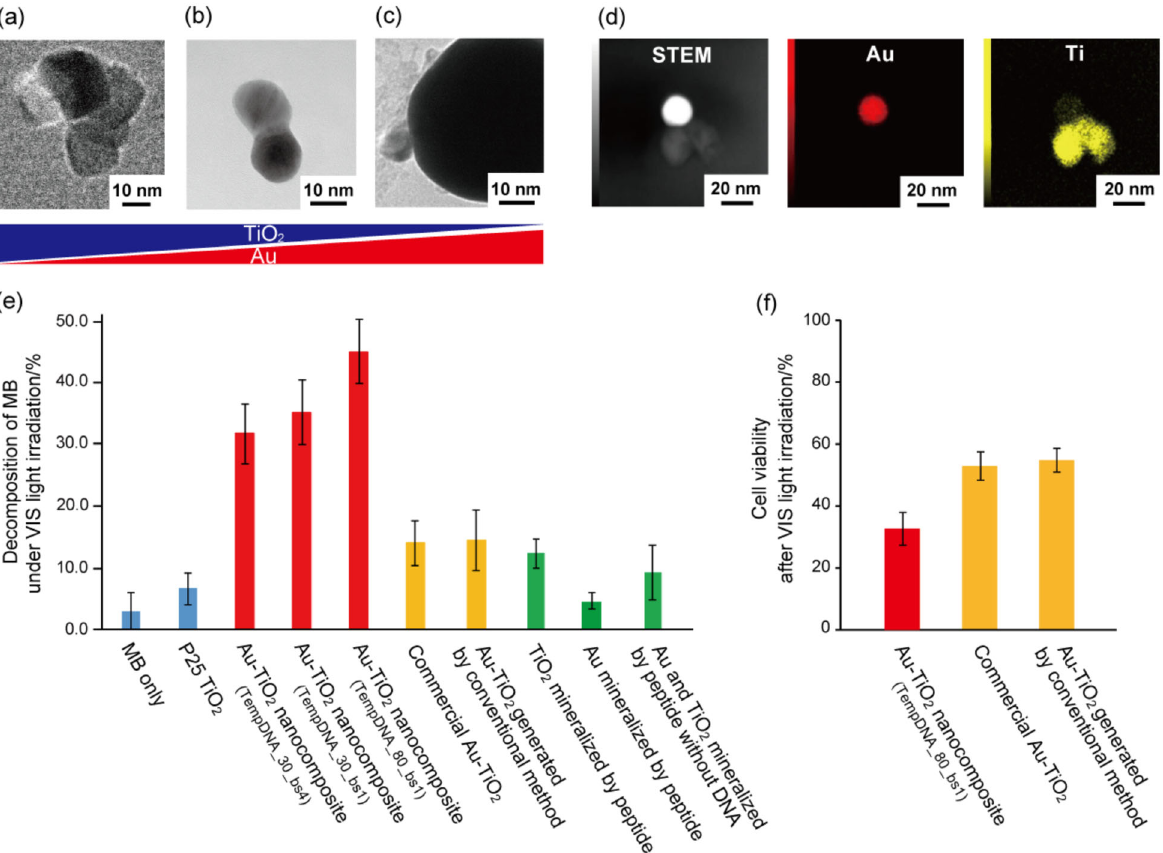
Fig. 2 Elemental composition control and of gold-titania nanocomposites and photocatalytic activity evaluation under visible light irradiation. TEM images of gold-titania nanocomposites with a TempDNA_30_bs4, b TempDNA_30_bs1, and c TempDNA_80_bs1. d TEM-EDX mapping images of gold- titania nanocomposite with TempDNA_30_bs4. e Decomposition of MB under visible light (>450 nm) irradiation using various titania, gold, and gold- titania samples. Results are the mean ± SEM, n = 3. f Cell death induction effect under visible light (>450 nm) irradiation of various gold-titania samples. Results are the mean ± SEM, n =